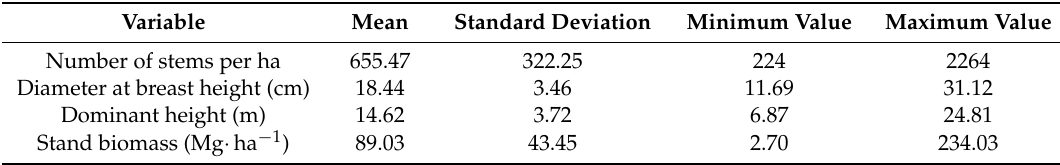
Table 1. Descriptive statistics of the main stand variables estimated from the 99 permanent sample plots. The dominant stand height was calculated as an average value from the 100 thickest trees per hectare.